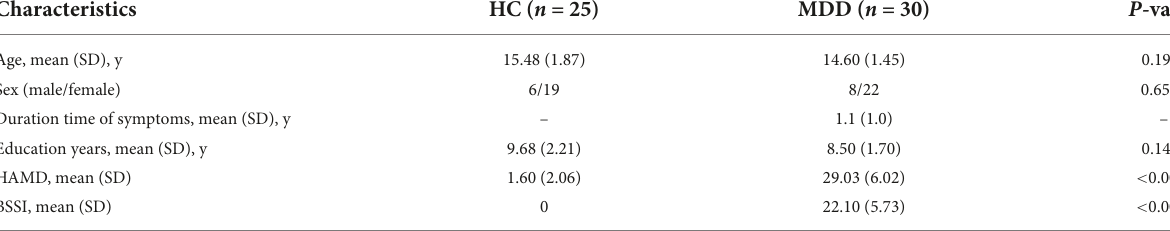
TABLE 1 Demographics and clinical characteristics between HCs and